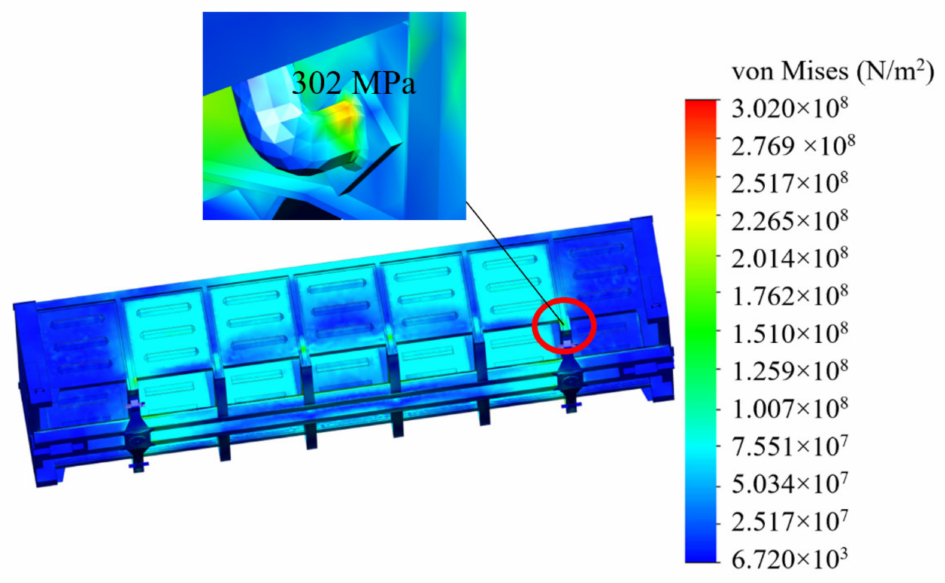
Figure 13. Results of the strength calculation for the bearing structure of an open car